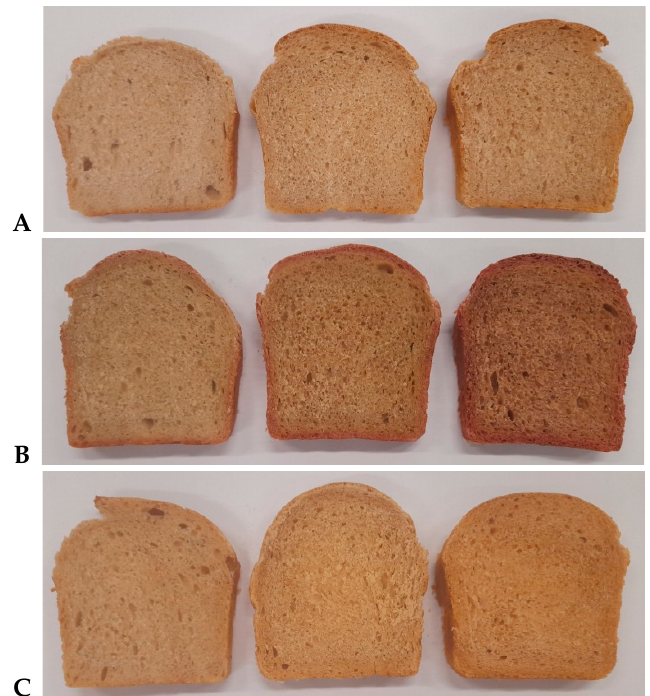
Figure A1. Pictures of the breads obtained in the experiment. ( A )—breads with tomato juice; ( B )—breads with beetroot juice; ( C )—breads with carrot juice in horizontal order on each picture: breads with 15, 30, 50% of water replacement with